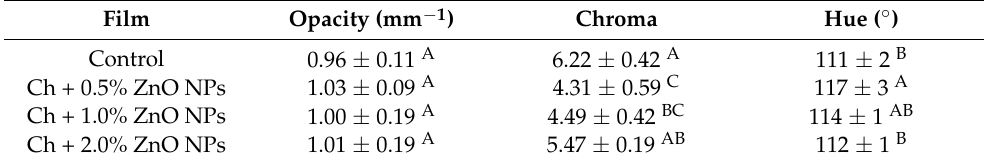
Table 3. Optical properties